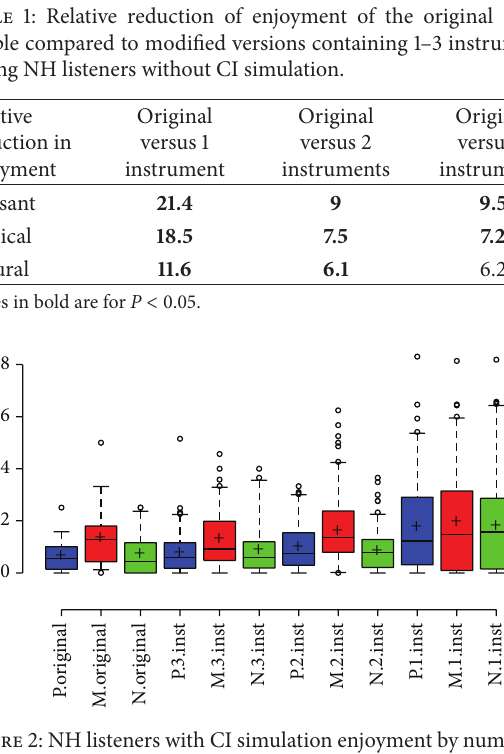
Figure 3: CI listeners enjoyment by number of instruments. CI listeners preferred modified segments comprised of a single instrument, two instruments, or three instruments compared to the original music sample. P: pleasant, N: natural, M: sounds like music, and Inst: instruments. Center lines show the medians, box limits indicate the 25th and 75th percentiles, whiskers extend to 5th and 95th percentiles, outliers are represented by dots, and crosses represent sample